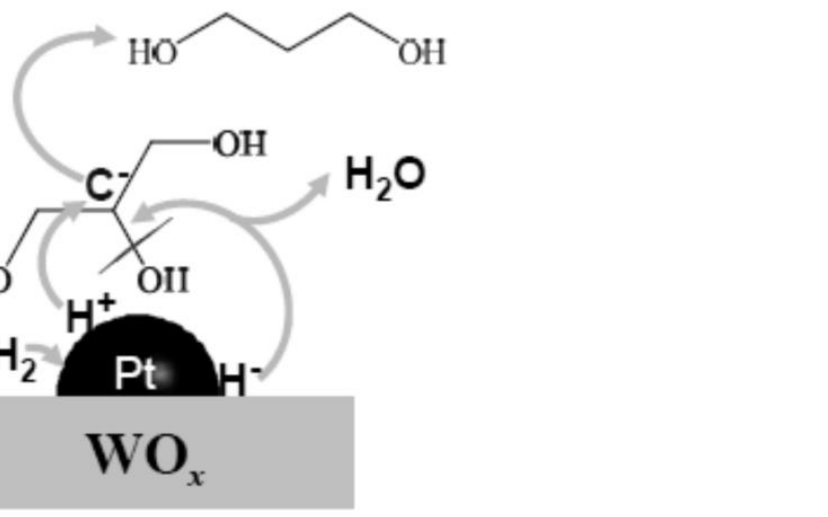
Figure 14. The reaction mechanism on the Pt/WOx catalysts. Reproduced from [63] with permission from Elsevier.